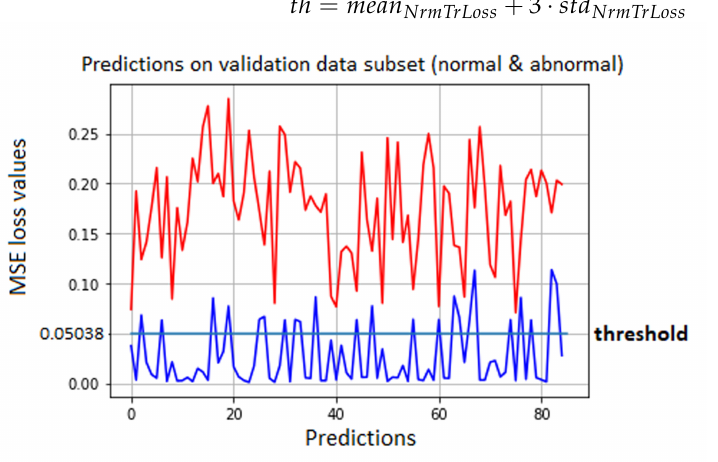
Figure 9. The threshold on the graphic of prediction loss values of both normal and abnormal traffic